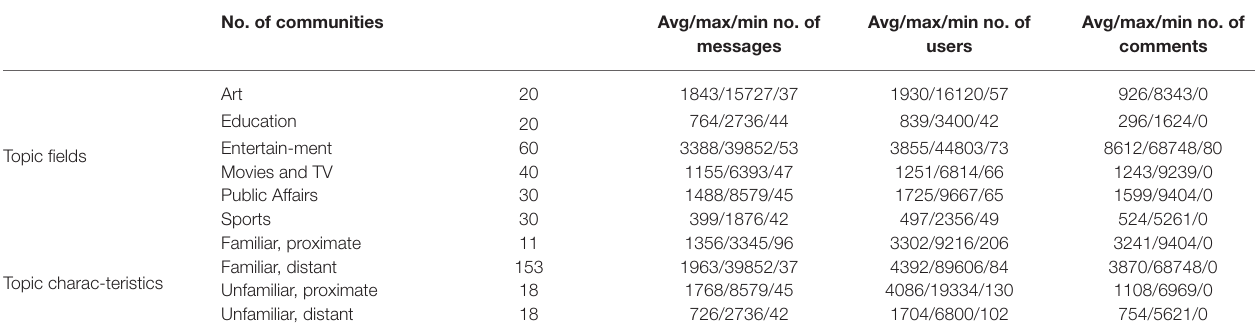
TABLE 1 | Statistics for the selected 200 topic-based communities on Weibo